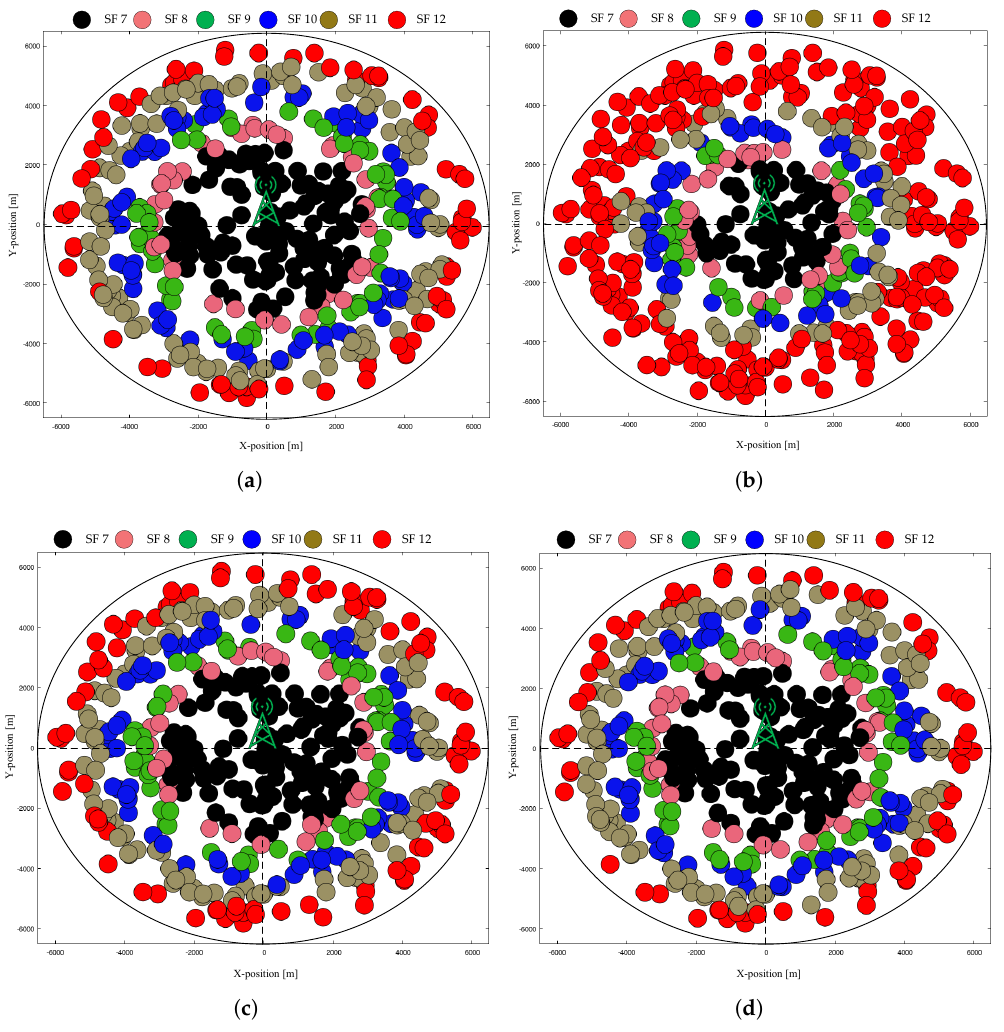
Figure 7. Final network topology in the case of static EDs with N = 500 and starting SF = 12: ( a ) typical ADR; ( b ) ADR+; ( c ) G-ADR, and ( d )